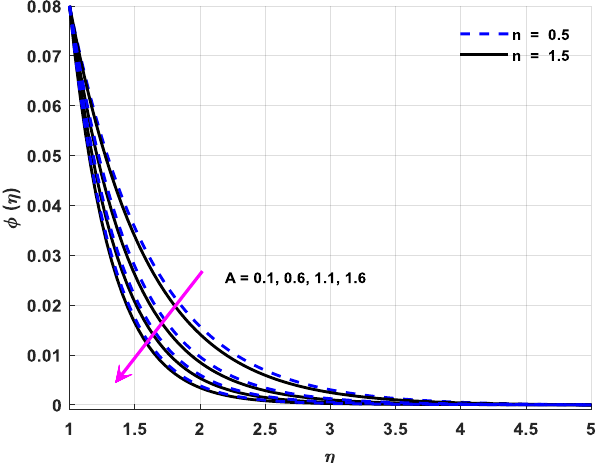
Figure 13. Variations in species concentration profiles owing to changes in A .